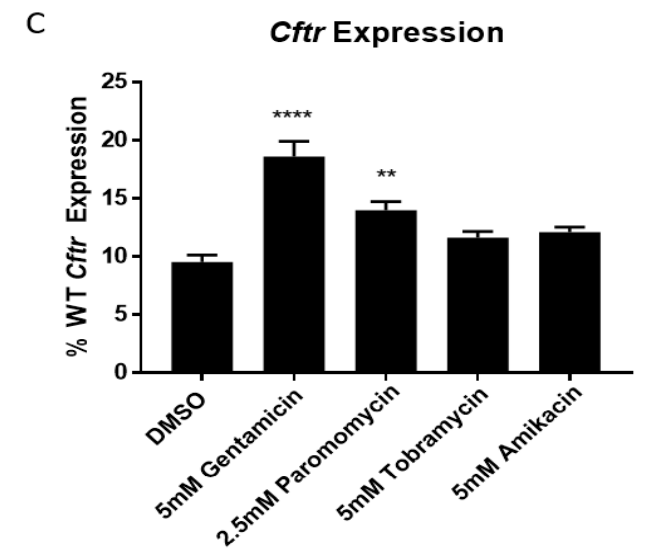
Figure 4. Gentamicin and paromomycin restore detectable levels of CFTR function. ( A ). Representative brightfield images of G542X intestinal organoids incubated with 2.5 mM of the indicated aminoglycosides 180 min after forskolin stimulation. Red arrows indicate expanded organoid lumens. Scale bar is 100 µm. ( B ). AUC measurements for four aminoglycosides at indicated doses. Each AUC is representative of 3–6 individual experiments. * p <0.05 ( C ). CFTR expression displayed as a percentage of WT Cftr expression. n = 3 wells per treatment group, ** p < 0.01; **** p < 0.0001 vs. untreated by one-way ANOVA with a Dunnett test.